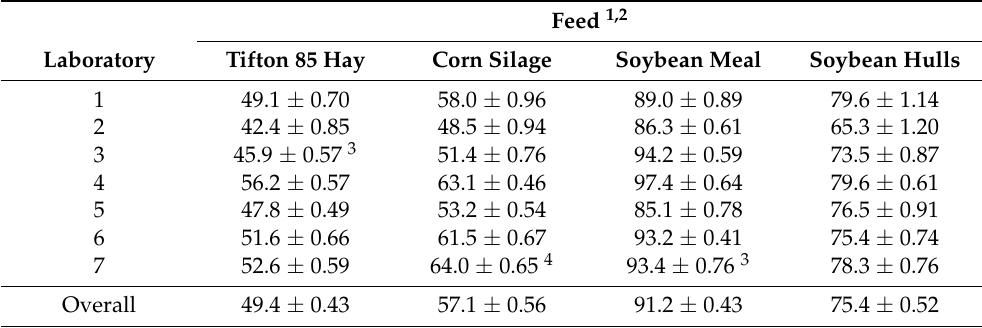
Table 2. Average in vitro dry matter digestibility (%) of different feeds, according to the laboratories participating in the collaborative